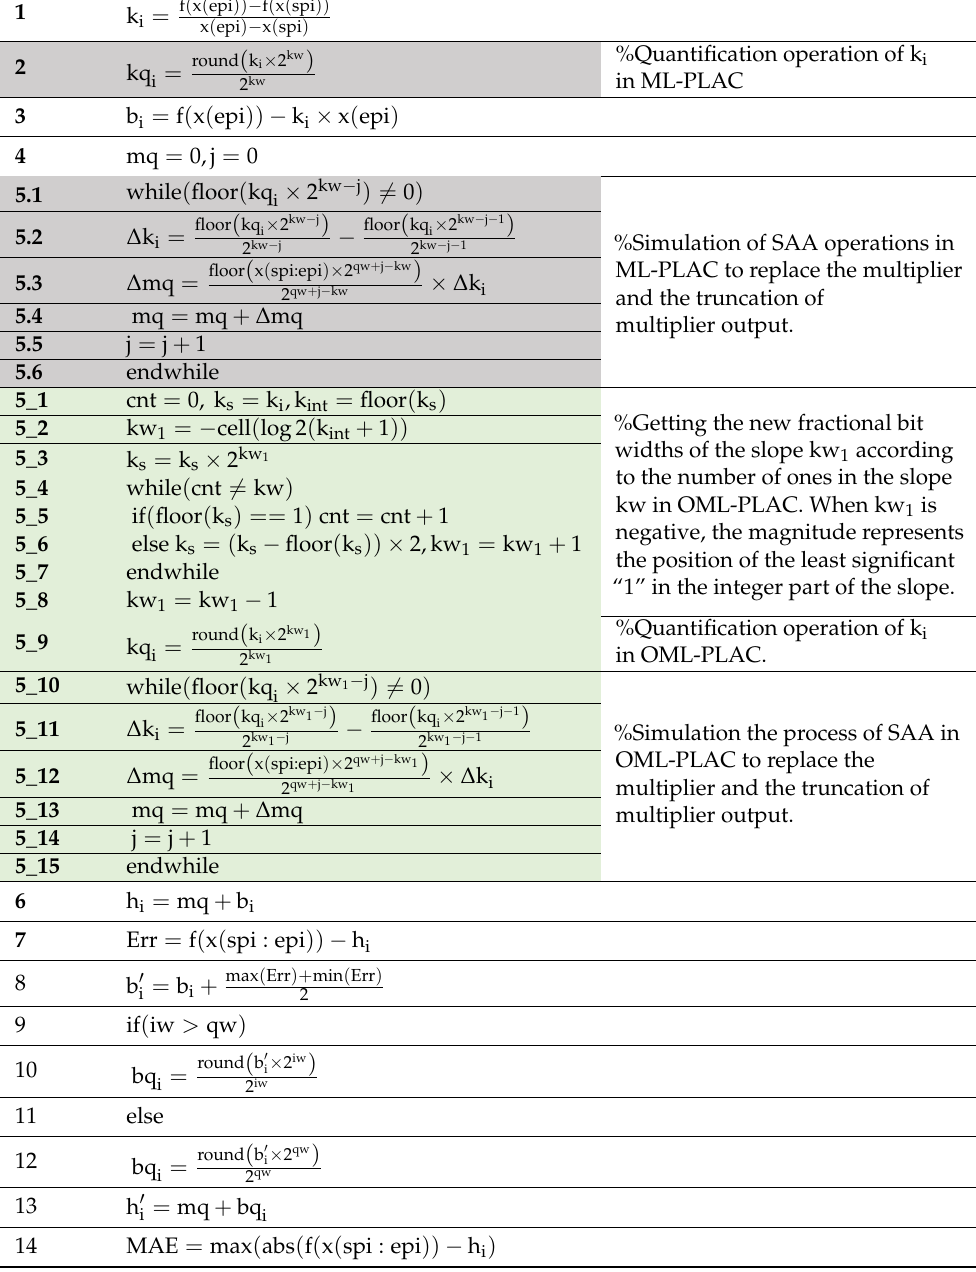
Table 2. Pseudocode for MAE calculation in ML-PLAC and